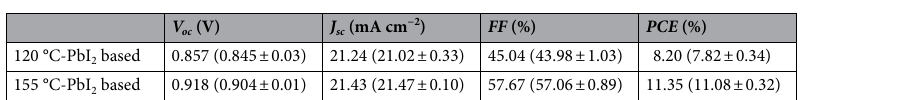
Table 2. Photovoltaic parameters of PSCs fabricated by chemical bath deposition-based method. The values in parentheses correspond to the average values from six devices and the corresponding standard deviation.